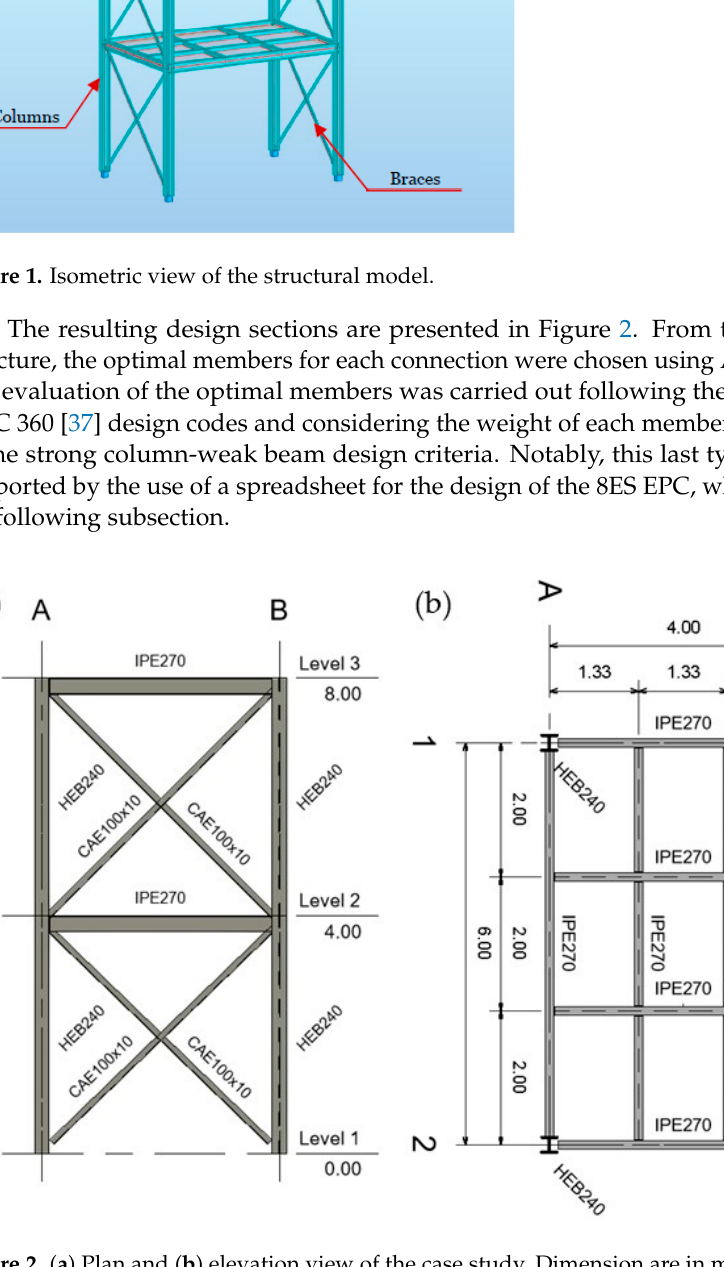
Figure 2. ( a ) Plan and ( b ) elevation view of the case study. Dimension are in meters.